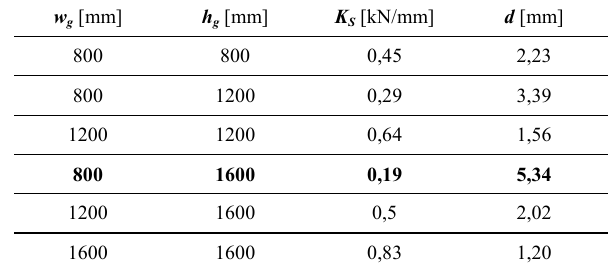
Table 2: In-plane stiffness and displacement of the system obtained for different panel dimensions.